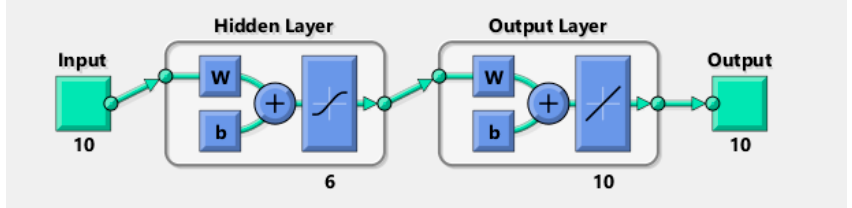
Figure 8. Neural network layout .